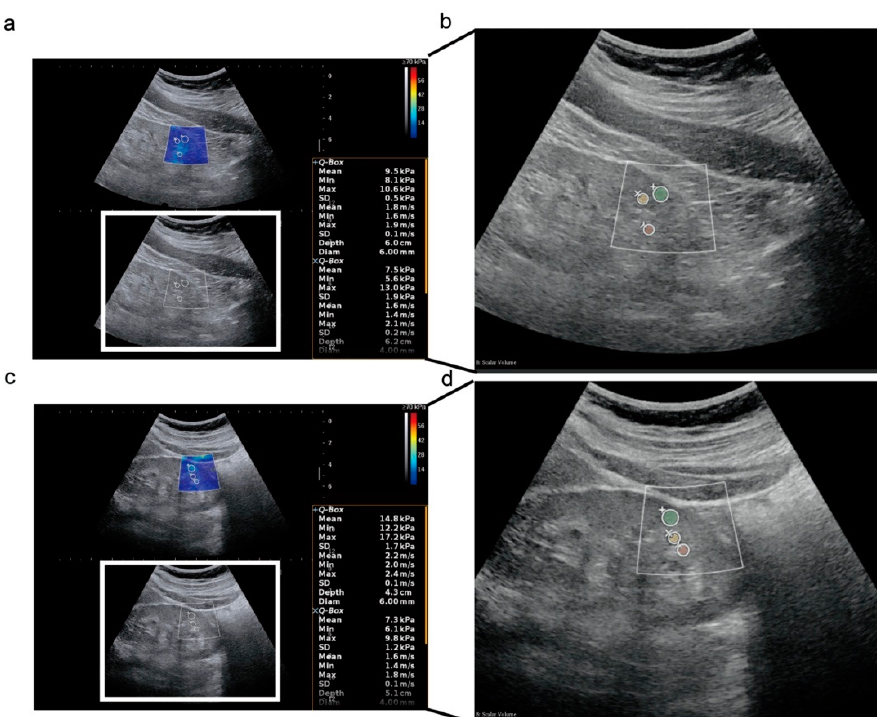
Figure 1. Two-dimensional shear wave elastography ultrasound images in a longitudinal plane. ( a , b ) Two-dimensional shear wave elastography ultrasound (2D-SWE) images and radiomics analysis of regions of interest (ROIs) in a 63-year-old female patient at CKD stage 3, who recovered to CKD stage 2 at the last follow-up. The SWE value from the single examination of the left kidney cortex was 9.5 kPa, shown in the right box; ( c , d ) 2D-SWE images and radiomics analysis of ROIs in a 28-year-old female patient at CKD stage 3, who progressed to CKD stage 5 at the last follow-up; (+), (Í), (å) represents left kidney cortex, sinus, and medulla, respectively; green, yellow, and red masks in ( b , d ) represent the ROI of left kidney cortex, sinus, and medulla, respectively, drawn for radiomics analysis according to the ROIs of 2D-SWE.